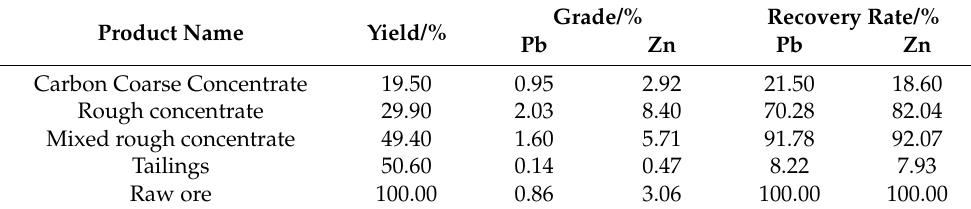
Table 5. Results of coarse ‐ grain mixed flotation test.